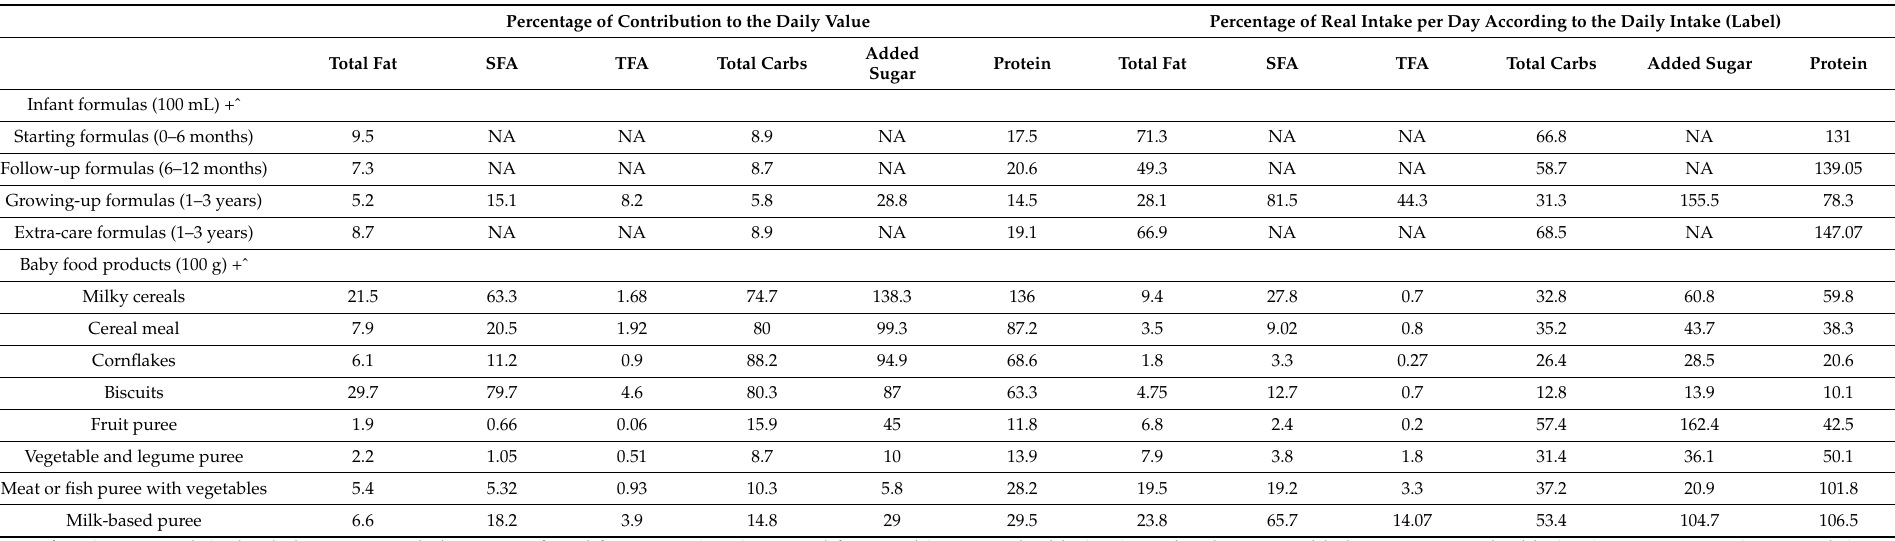
Table 2. The percentage of daily value of infant formulas and baby food products for the amount of total fat, saturated fatty acids, trans fatty acids, total carbs, added sugar, and protein based on daily recommended